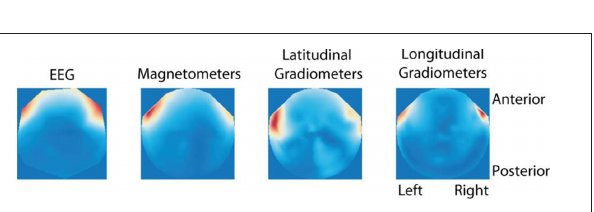
Figure A4 | Mean power of the spatial projections of those independent components having the highest correlations with the HeOg signal.